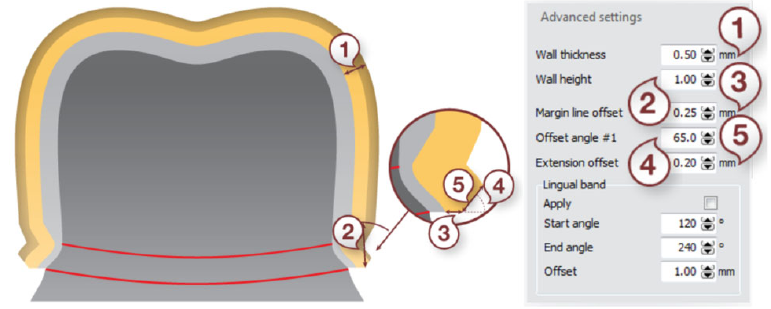
Figure 5. Design parameters: (1) wall thickness, (2) wall height, (3) margin line offset, (4) offset angle